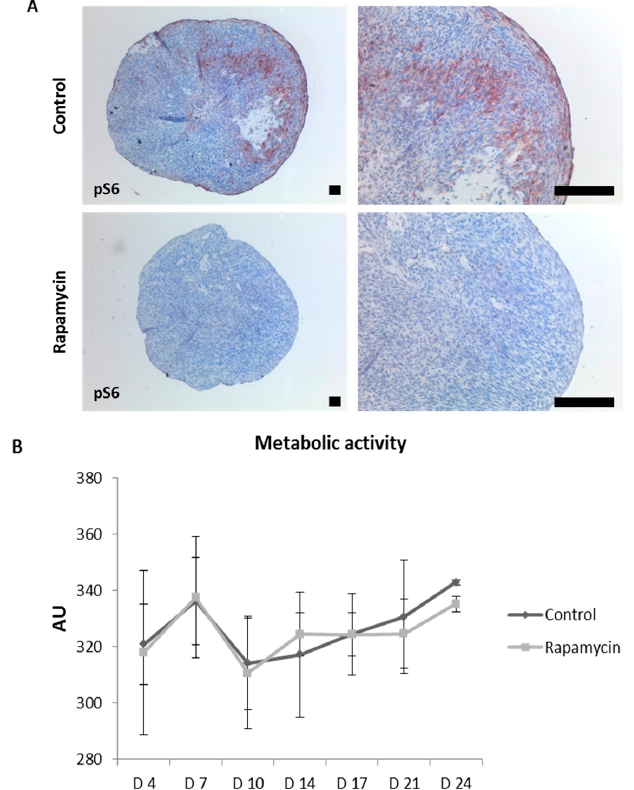
Figure A1. Effect of mTORC1 inhibition on metabolic activity of patient-derived OA chondrocytes. To verify effectiveness of rapamycin, patient-derived chondrocyte pellets were stained for the